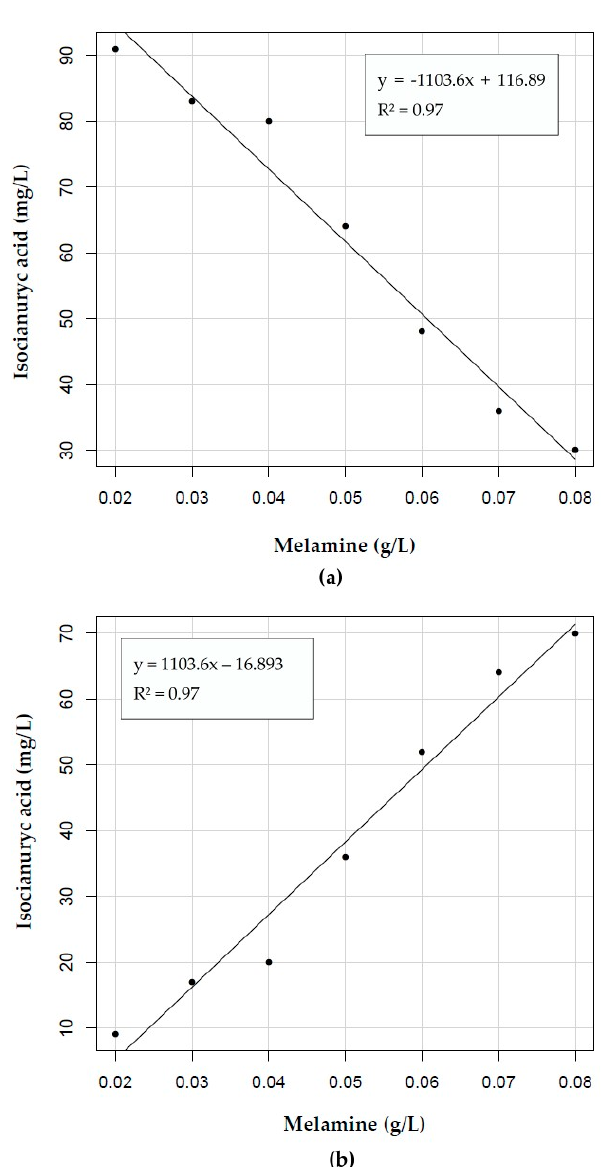
Figure 5. Range of melamine additions (0.02–0.08 g/L): ( a ) Variation of isocyanuric acid residual in the filtered water, ( b ) variation of isocyanuric acid removed in the filtered water.